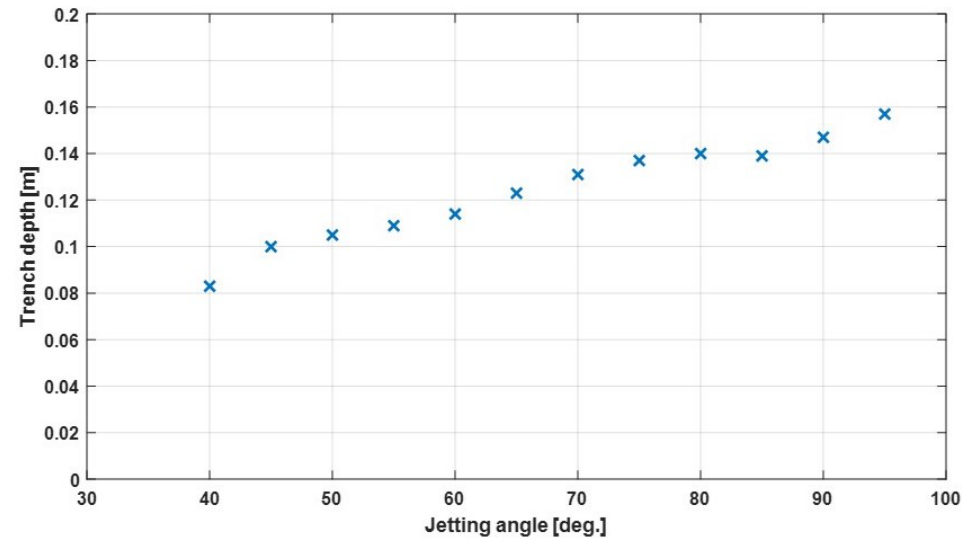
Figure 5. Jetting angle vs. trench depth.